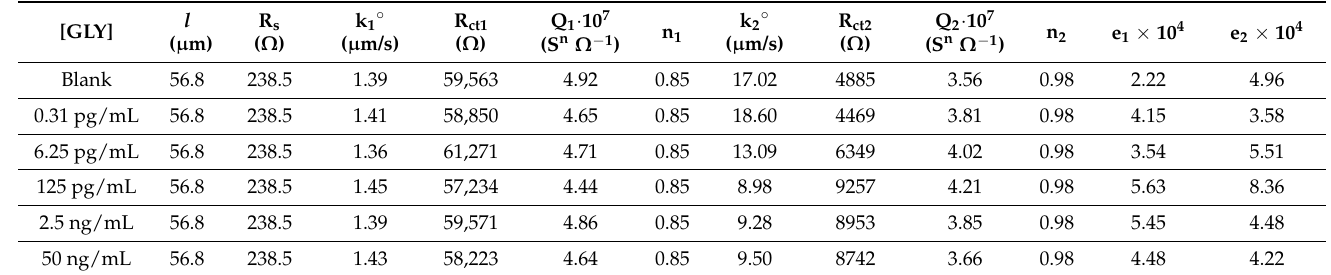
Table 3. Different parameters of CS-NIP/CMA/Au estimated by the model for different concentra- tions of GLY.